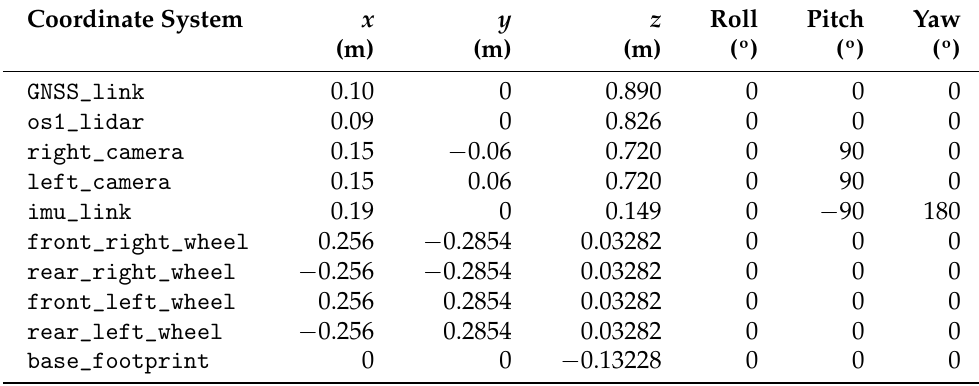
Figure 3. Reference frames employed in the Gazebo model of Husky. Their X , Y and Z axes are represented in red, green and blue colors, respectively. Table 2. Relative poses of all the robot reference frames with respect to base_link